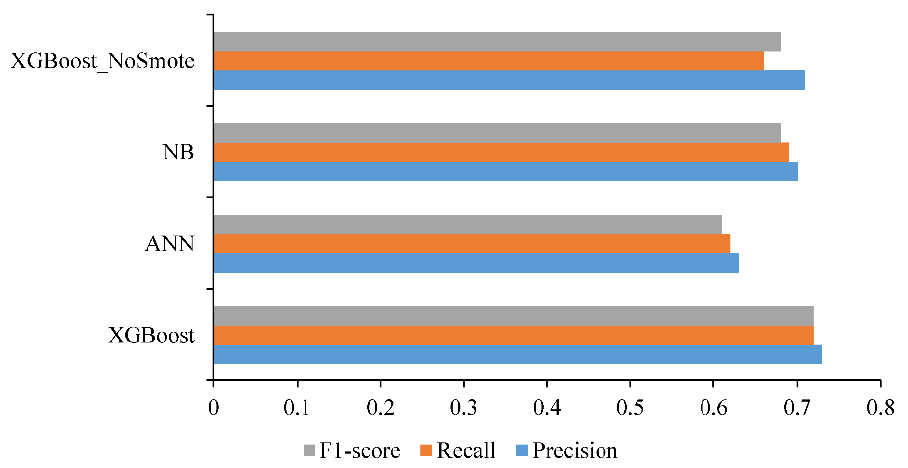
Figure 11. F1 score of different machine learning methods.